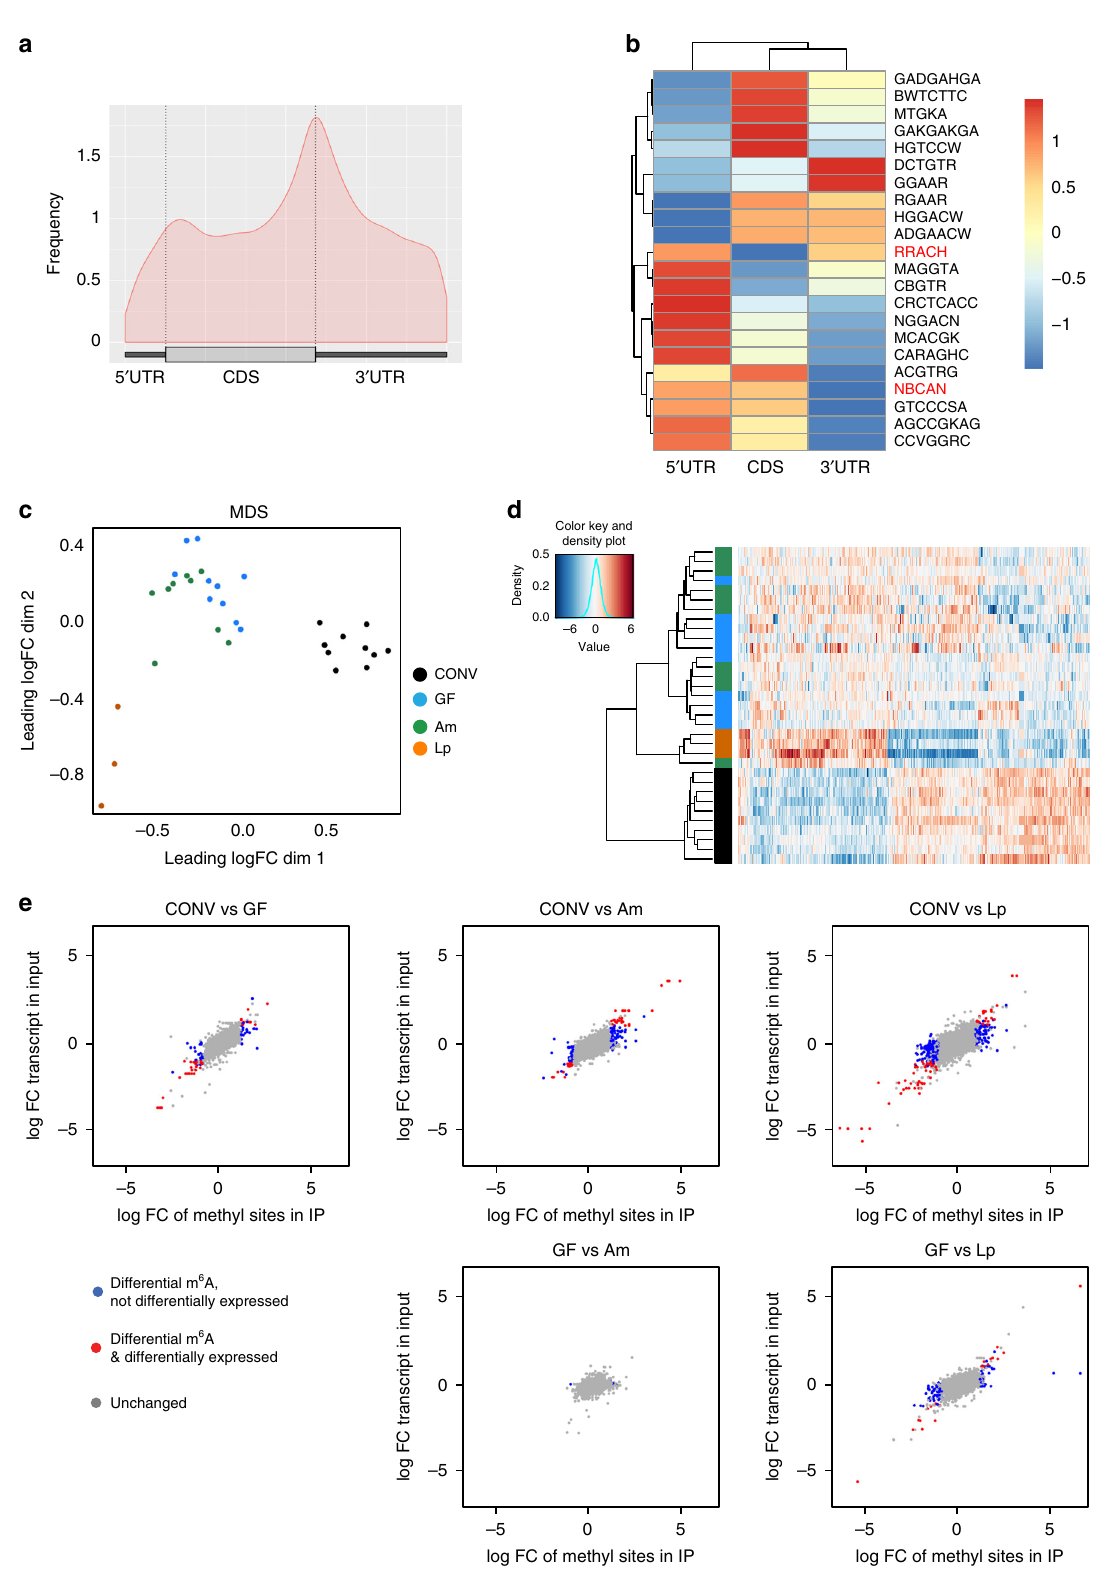
microbiota, numbers of cell types are not signi fi cantly changed in the absence of a microbiota, which is the case for many immune cells 37 . Taken together, epitranscriptomic modi fi cations represent a novel mechanism of commensal-host-interaction in the intestine,